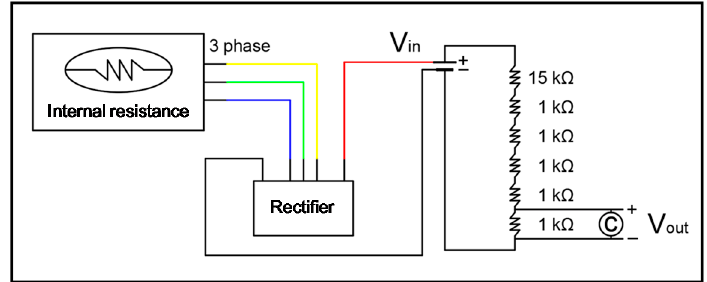
Figure 5. Schematic of a voltage divider circuit.